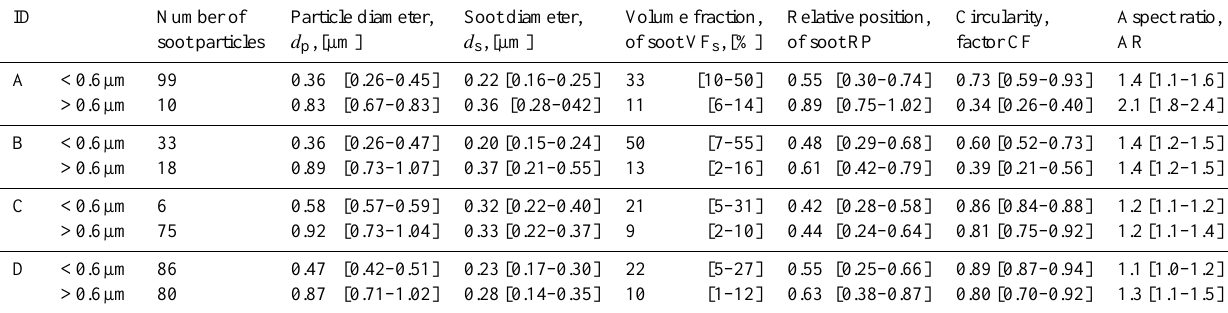
∗ Values in square brackets show the 25th–75th percentile values.